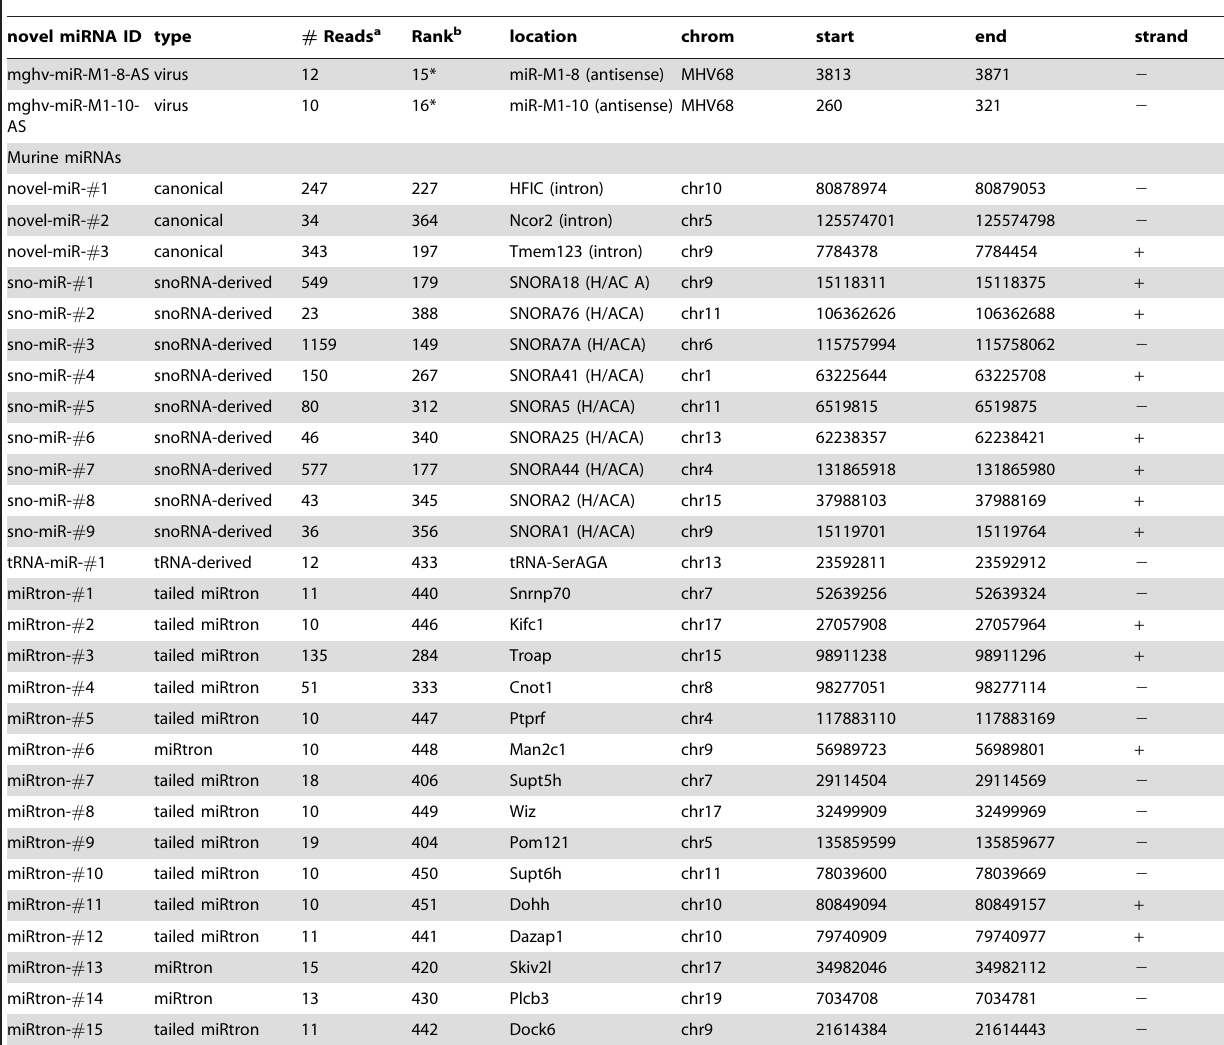
Table 1. Thirty novel miRNAs in the MHV68 or mouse